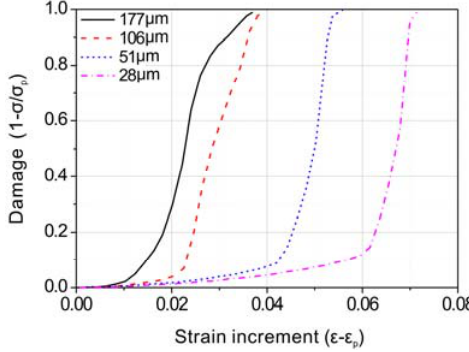
Figure 9. Damage evolution after peak strain for specimens with precipitates during tension test; ε p is the peak strain.